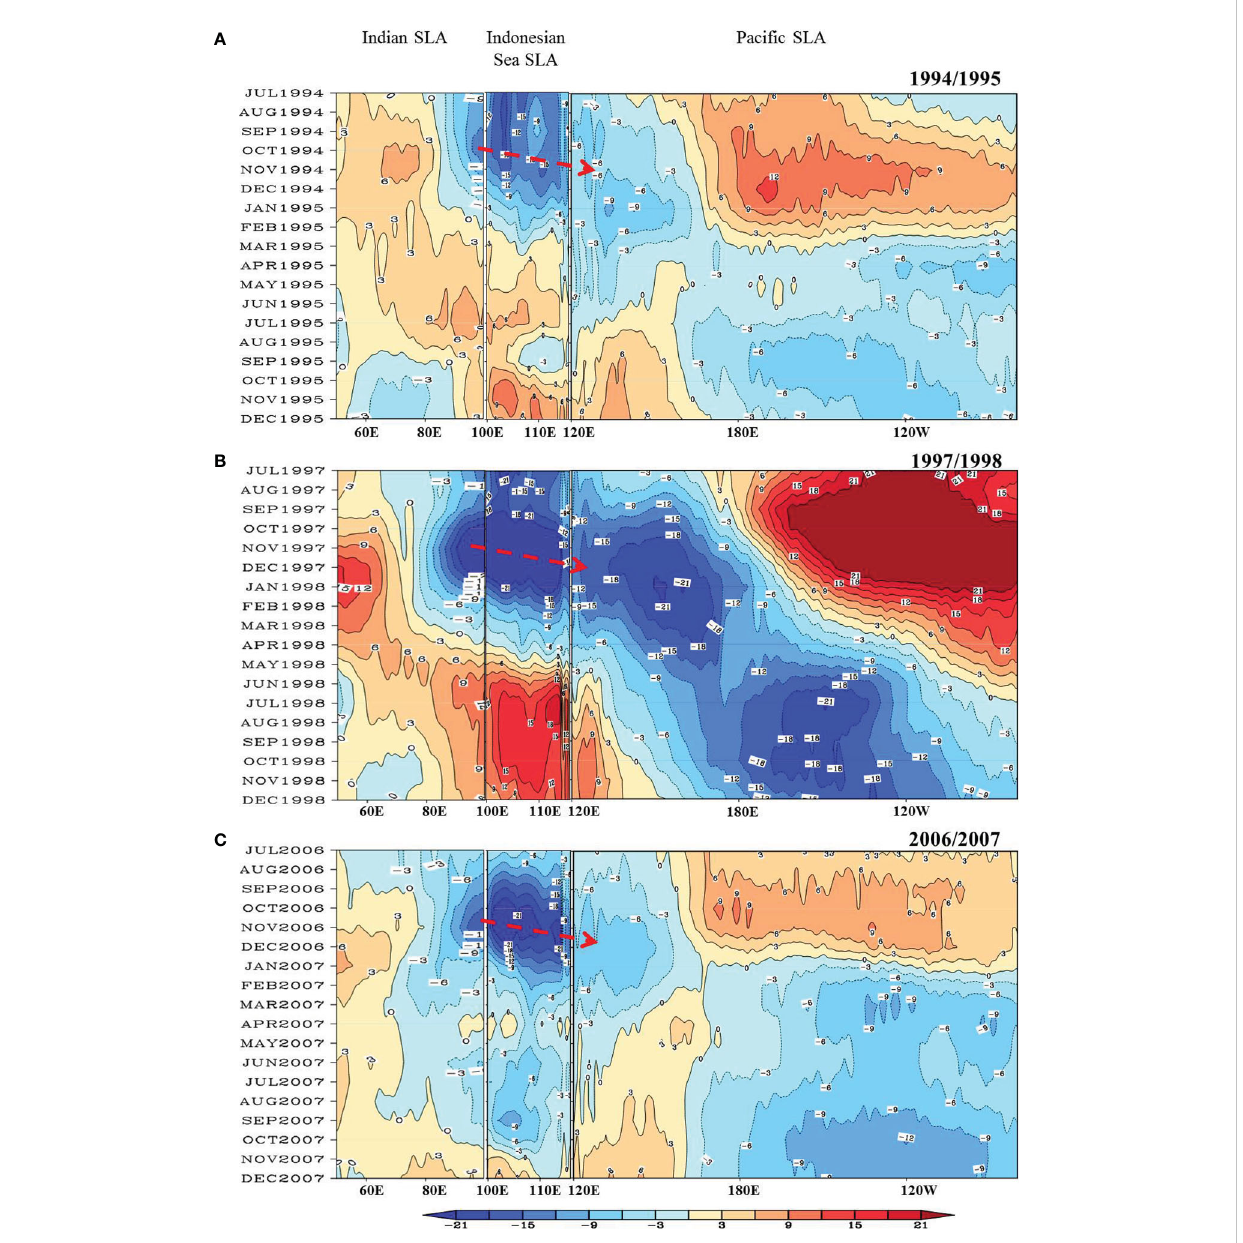
FIGURE 11 The “ oceanic channel ” dynamics during the historical La Niña events. SLA (cm) over the equatorial Indian and Paci fi c Ocean (1°S-1°N) and alongshore the Sumatra-Java island chain during the 1994 (A) , 1997 (B) , 2007 (C) pIOD. The red dashed arrows indicate the eastward-propagating Kelvin